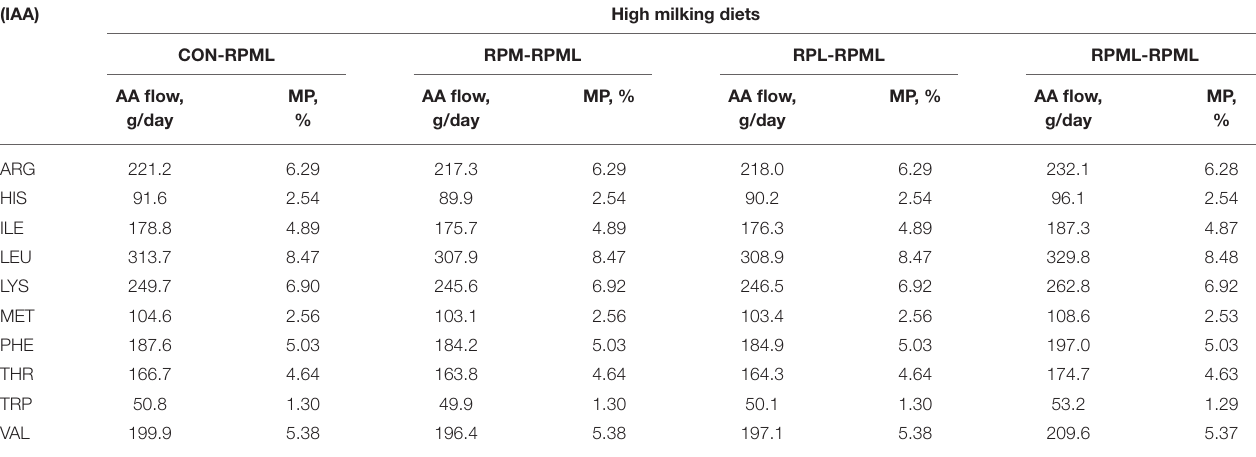
TABLE 3 | Duodenal flows of the indispensable amino acids (IAA) based on the actual consumed DMI during high milking period 1 using CNCPS v6.5.